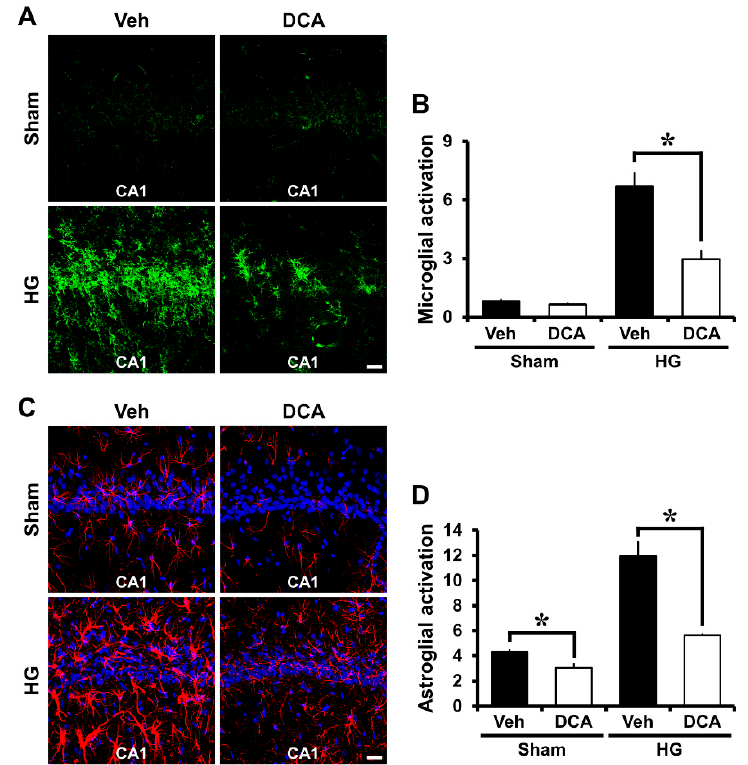
Figure 4. Administration of DCA decreases microglia and astrocyte activation after hypoglycemia. To detect microglia activation, we conducted CD11b staining. Hypoglycemia-induced microglia activation triggers an immune response. CA1 is vulnerable to damage by activated microglia. ( A ) The green fluorescence (CD11b staining) shows activated microglia in the hippocampal CA1 area. Sham-operated group shows almost no microglial activation. However, after hypoglycemia, microglia cell number, intensity, and morphology were greatly enhanced in the vehicle-treated group compared to the DCA-treated group. Scale bar = 20 µ m. Data are mean ± S.E.M., n = 5 for each sham group, n = 8 for each hypoglycemia group. ( B ) The grade of microglia activation in the CA1. ( C ) The red fluorescence (GFAP staining) shows activated astrocyte in the hippocampal CA1 area. The sham-operated group shows almost no astrocyte activation. However, after insult, DCA administration prevented astrocyte activation in the CA1. Scale bar = 20 µ m. ( D ) The graph represents the intensity of activated astrocytes in the CA1 region. Data are mean ± S.E.M., n = 3 for each sham group and hypoglycemia group. * Significantly di ff erent from vehicle treated group, p <